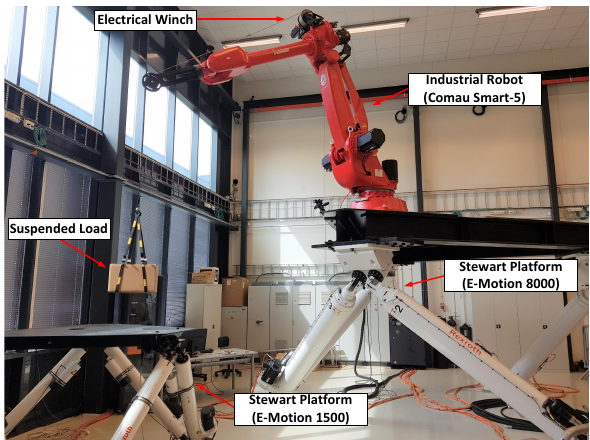
Figure 1: An overview of the experimental setup at the Norwegian